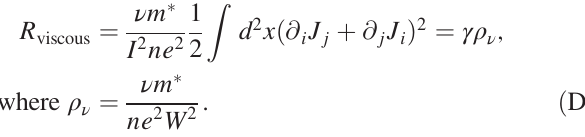
TABLE III. Parameters of electron system organized in four sections. First is Fermi-energy-related scales, controlled by the effective electron mass (GaAs is chosen) and density. Second is the scales related to the e - e and e -ph collisions that determine resistivity and viscosity. Third, the geometric and ambient parameters are listed. Finally, the dimensionless numbers of flow are given. Note that the Reynolds number is low, indicating Stokes or “ creeping ” flow with Ohmic corrections depending on